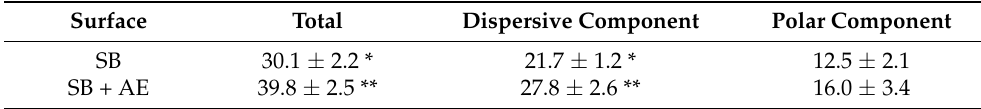
Table 4. Surface energy (mJ/m 2 ) and its components for the different Ti surfaces. Values are mean ± standard deviation. Statistical differences for each column are indicated by single-asterisk and double-asterisk symbols ( p <